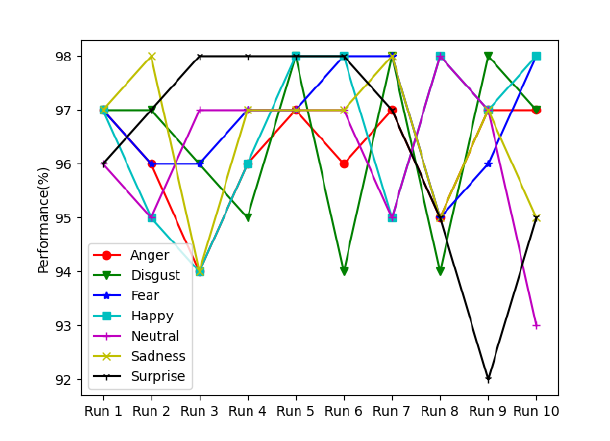
Table 3. Comparison with State-of-the-art methods